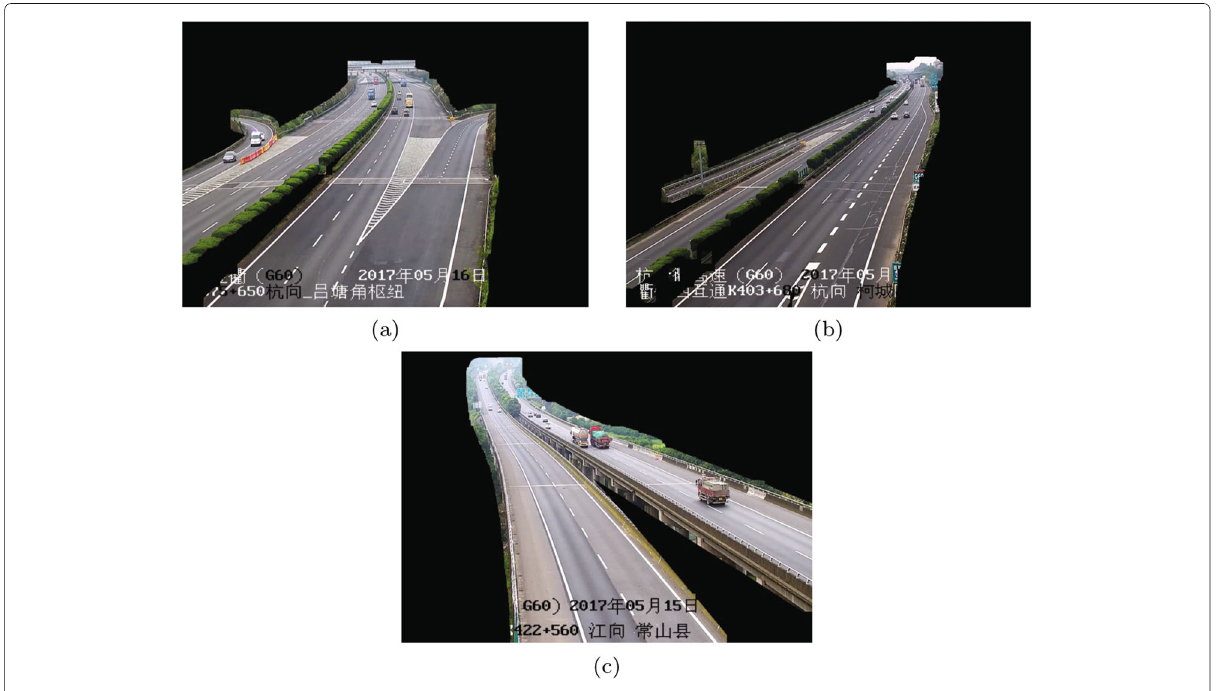
Fig. 7 Road surface extraction results for different highway scenarios. a Scene 1; b Scene 2; c Scene